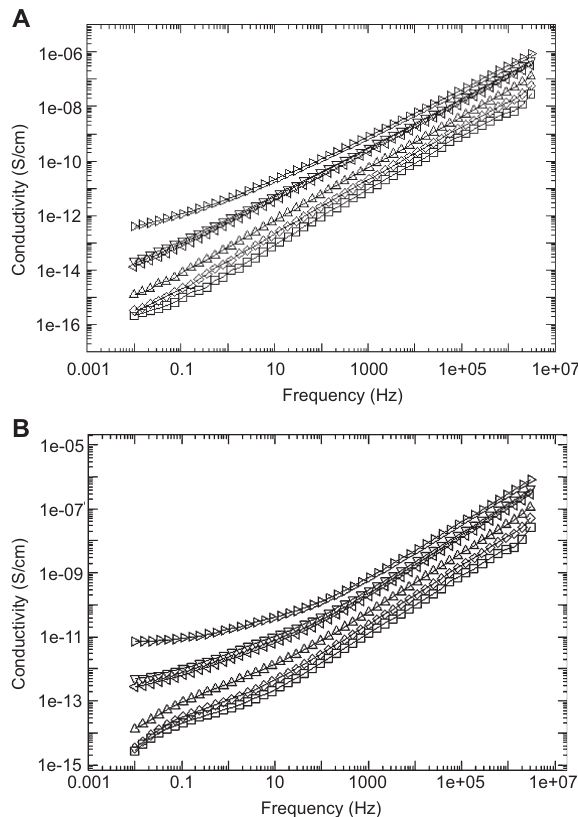
Figure 5 Conductivity σ for PS/GTR compounds at 30 ° C (A) and 120 ° C (B) in relation to frequency: □ PS+5% GTR; ◊ PS+10% GTR;  PS+20% GTR;  PS+40% GTR;  PS+50% GTR;  PS+70% GTR.